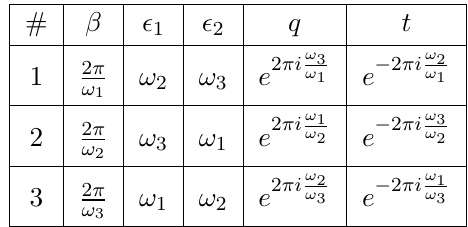
Table 1 . Parameters entering the q -deformed Nekrasov partition function at three (cid:12)xed points on a squashed S 5